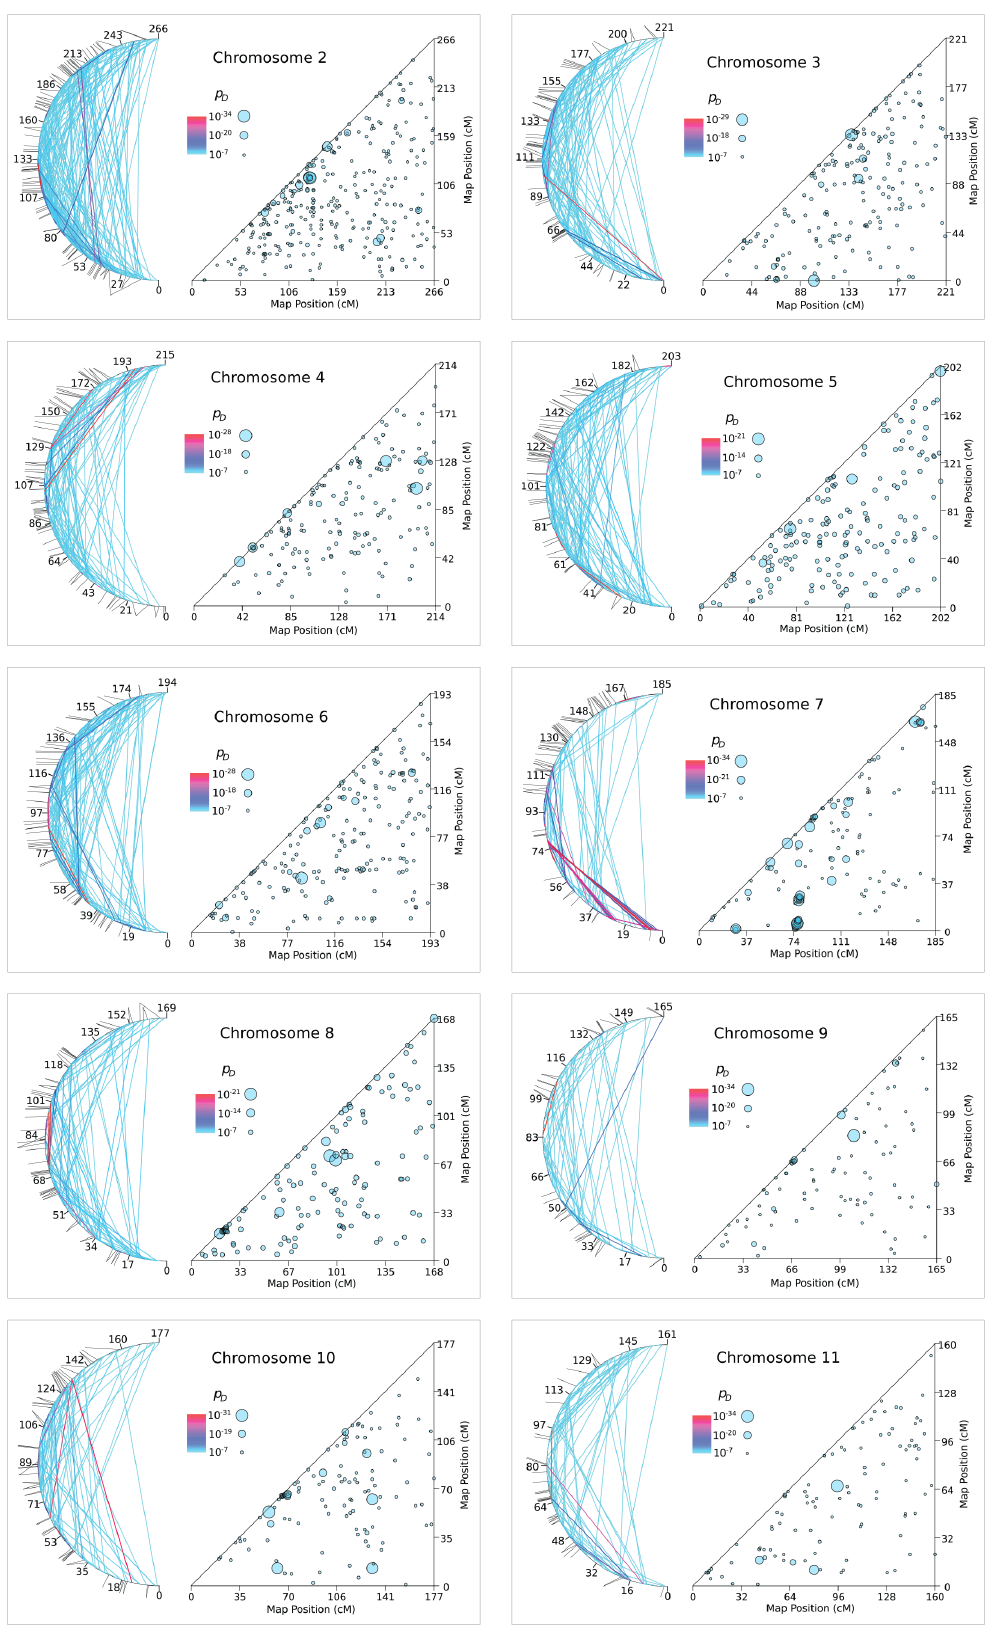
Figure 5. Patches of LRLD on autosomes 2 to 11.